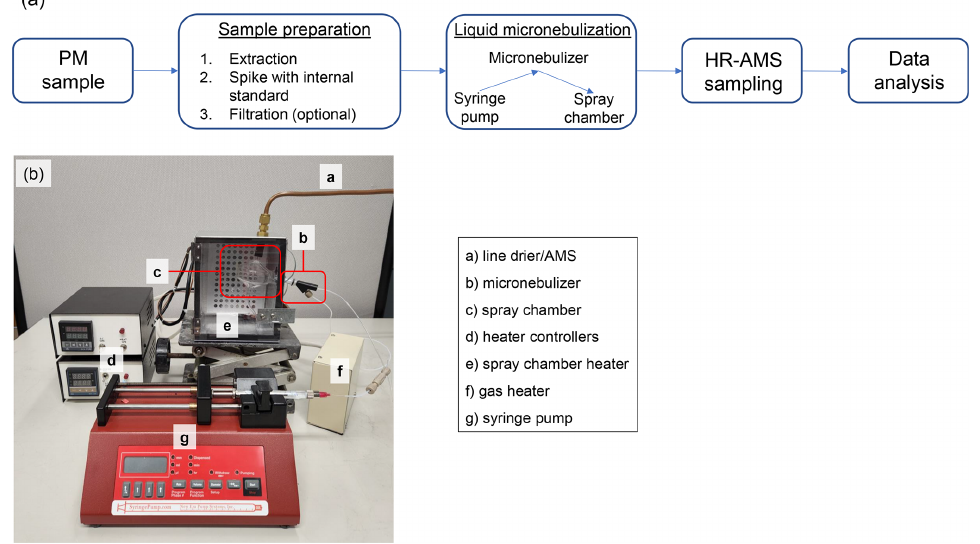
Figure 1. (a) A schematic overview of our microextraction and analysis methodology. (b) A picture of the micro-flow nebulization